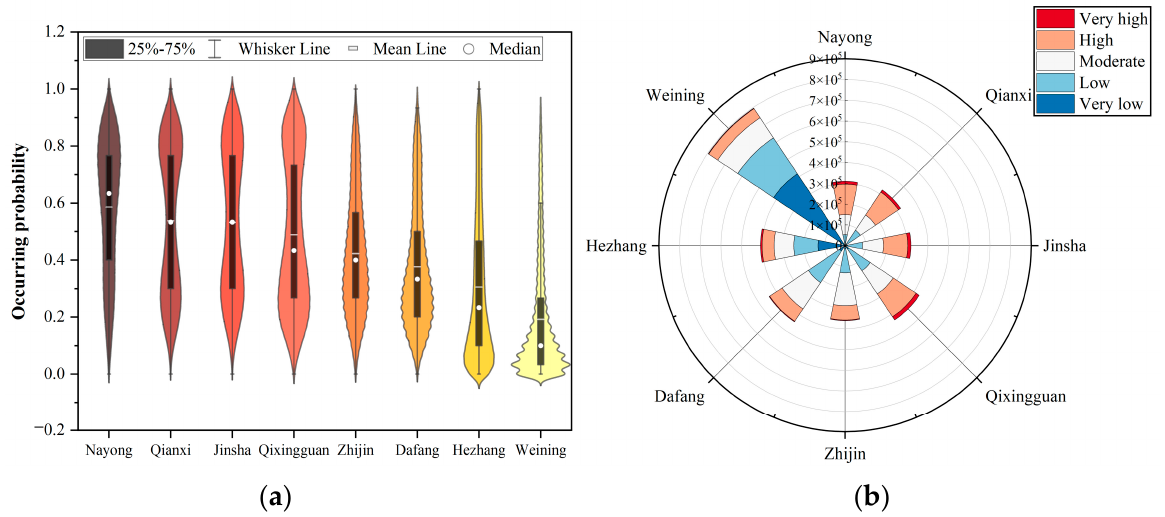
Figure 11. Landslide susceptibility statistics at the county level in Bijie. ( a ) Numerical distributions of hazard occurrence probability in all raster cells of each county. ( b ) Numbers of raster cells in different susceptibility levels of each county. For ( a ), the two ends of the whisker line are the maximum and minimum values of the corresponding box plot, and the width of the violin plot reflects the density of data at that location, with a greater width representing a greater density.